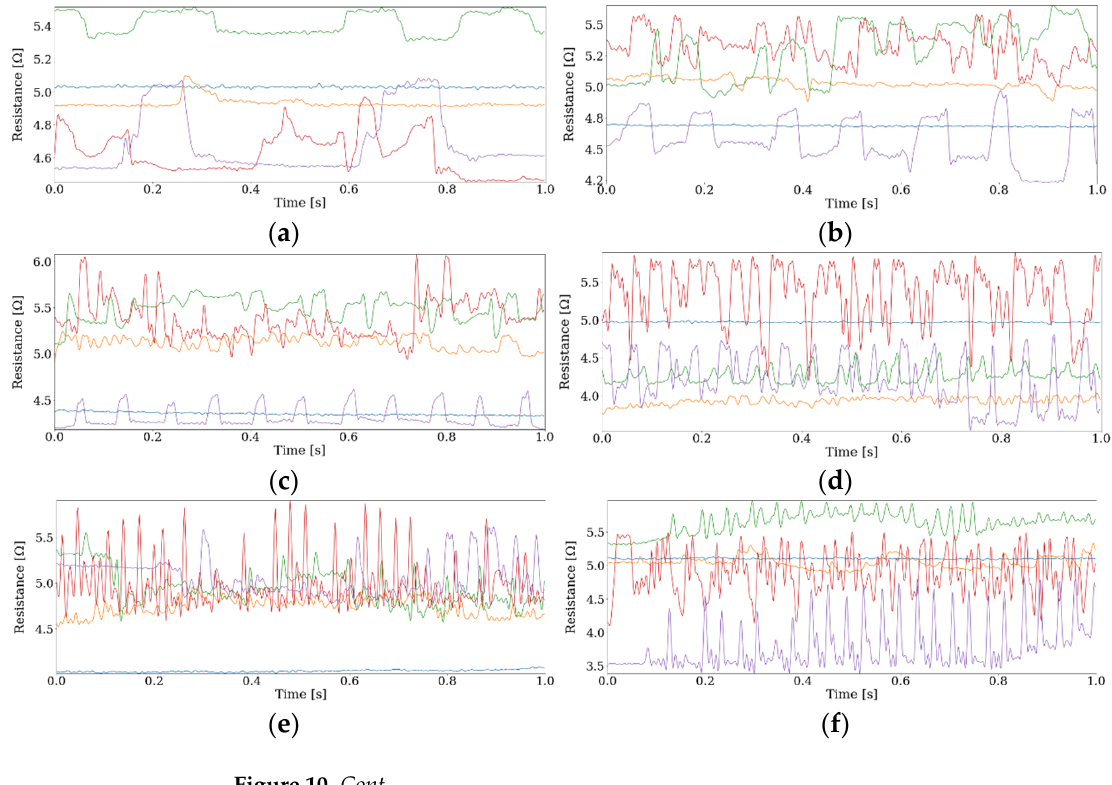
Figure 9. Selected five materials with different textures.